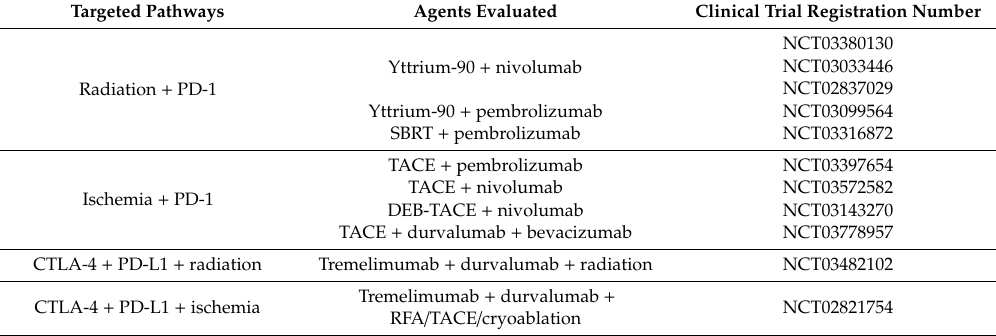
Table 3. Selective ongoing clinical trials of the combination of immunotherapy agents with liver-directed therapies.